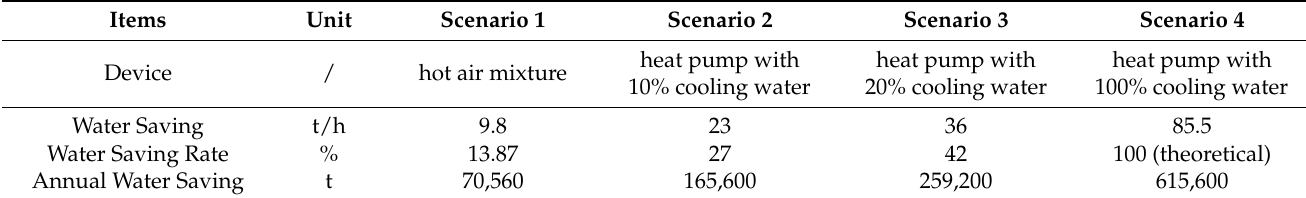
Table 3. Water saving performance comparison of several technical